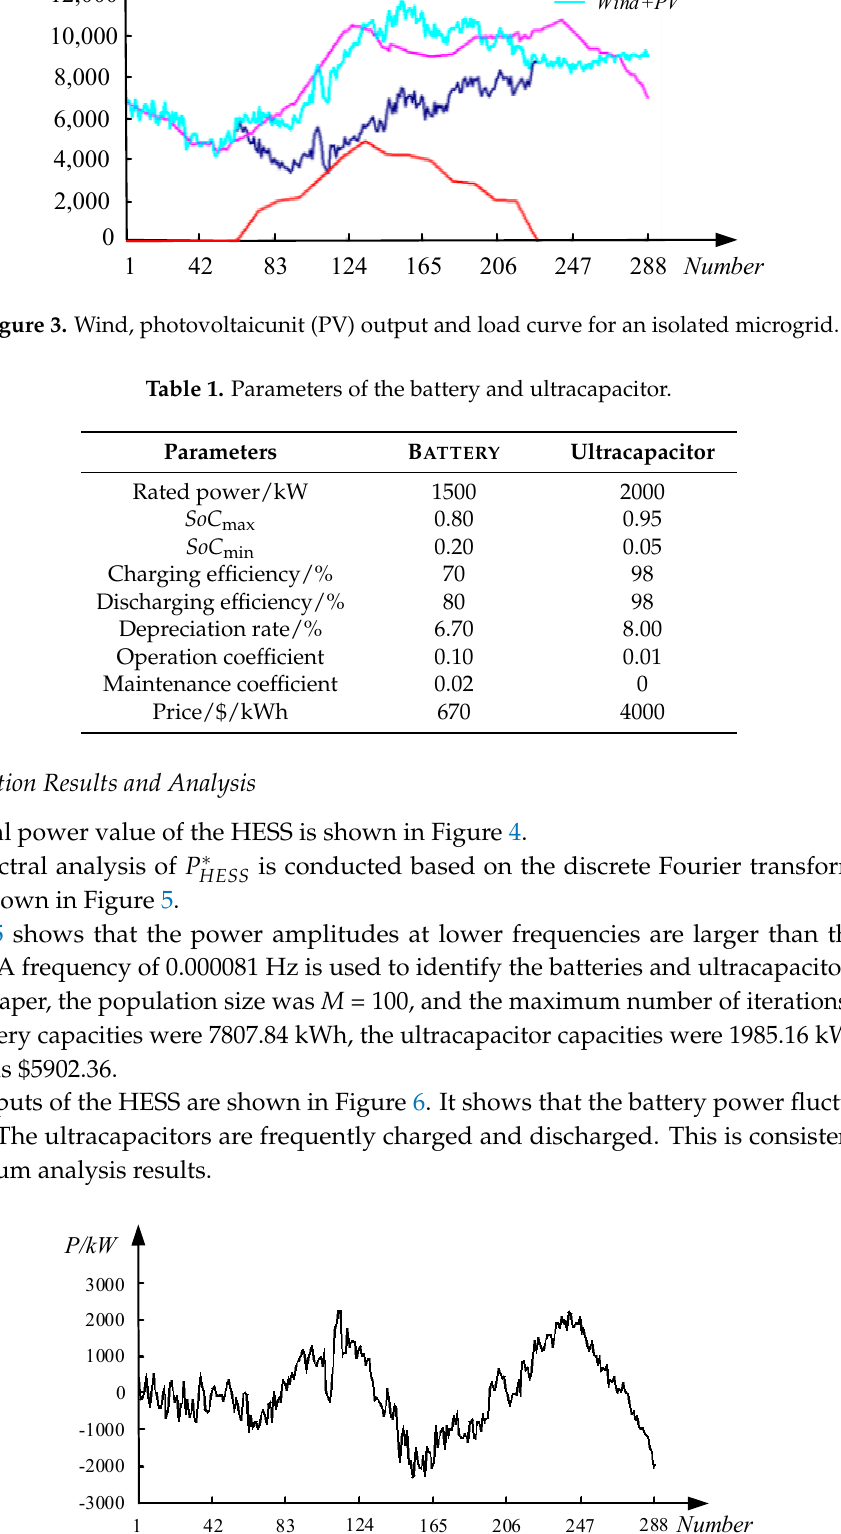
Figure 4. Ideal power value of the hybrid energy storage systems (HESS), P *